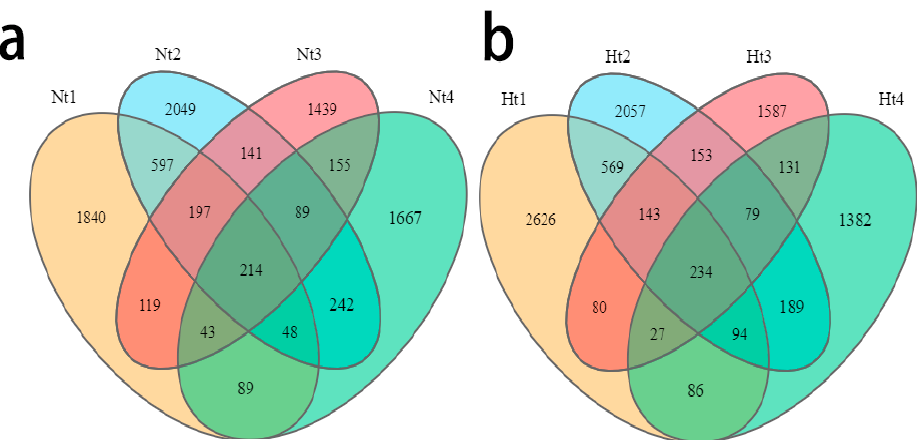
Figure 5. Core ASVs of different months. ( a ), ( b ), Veen diagram showing the distribution of ASVs, displaying the extent of the core and exclusive ASVs across the 4 months in the Nt and Ht groups, respectively. Nt: normal seawater temperature; Ht: 3 °C higher temperature; 1, 2, 3, and 4 represent May, June, July, and August, respectively.